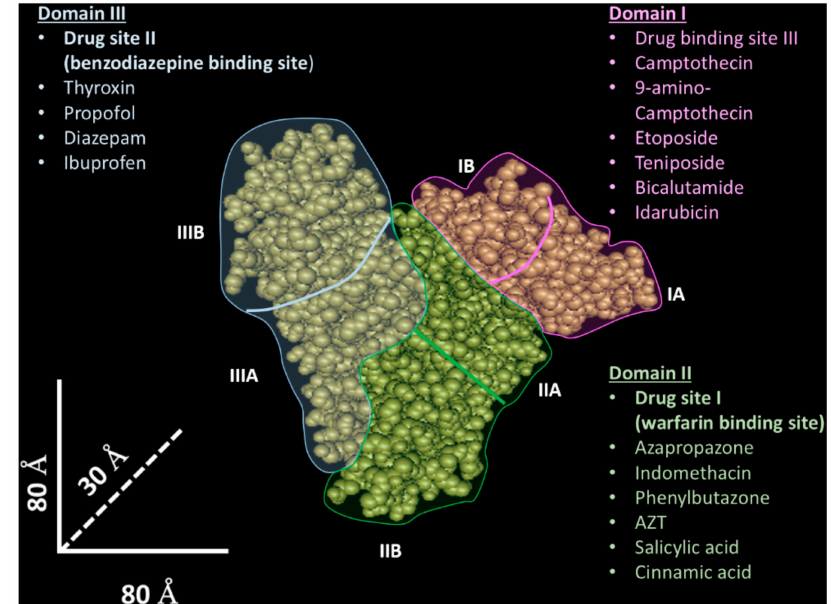
Figure 1. Tridimensional albumin structure and drug binding sites. The albumin tridimensional structure (source National Center for Biotechnology Information- https: // www.ncbi.nlm.nih.gov / ) is composed of three domains (I–III) highlighted with di ff erent colors (light blue—domain I; green—domain II; pink—domain III). Other binding sites interacting with ions, small molecules, and peptides are not